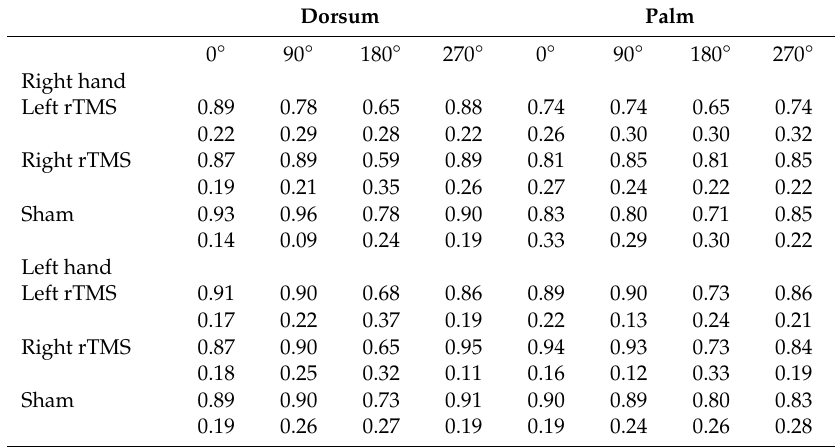
Table 1. Mean accuracy and SD, separately for hand view (dorsum and palm), orientation (0 ◦ , 90 ◦ , 180 ◦ , and 270 ◦ ), laterality (left and right), and stimulation condition (left, right, and sham). Dorsum